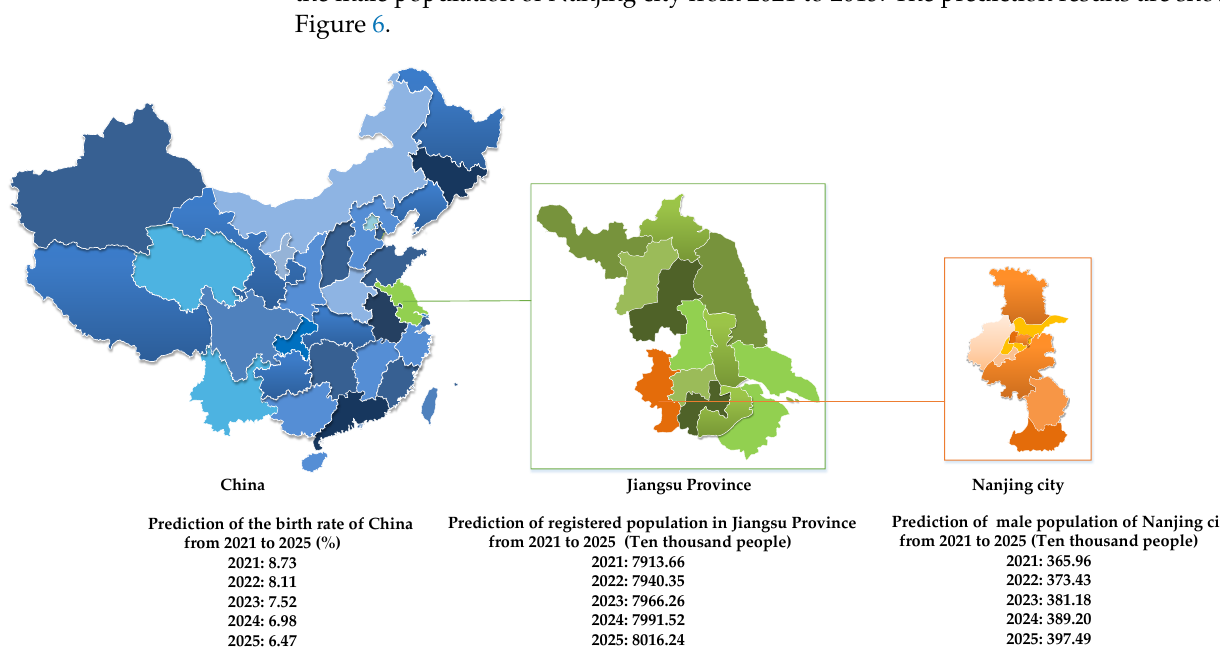
Figure 6. Projections of the size and structure of China ’ s population from 2021 to 2025.